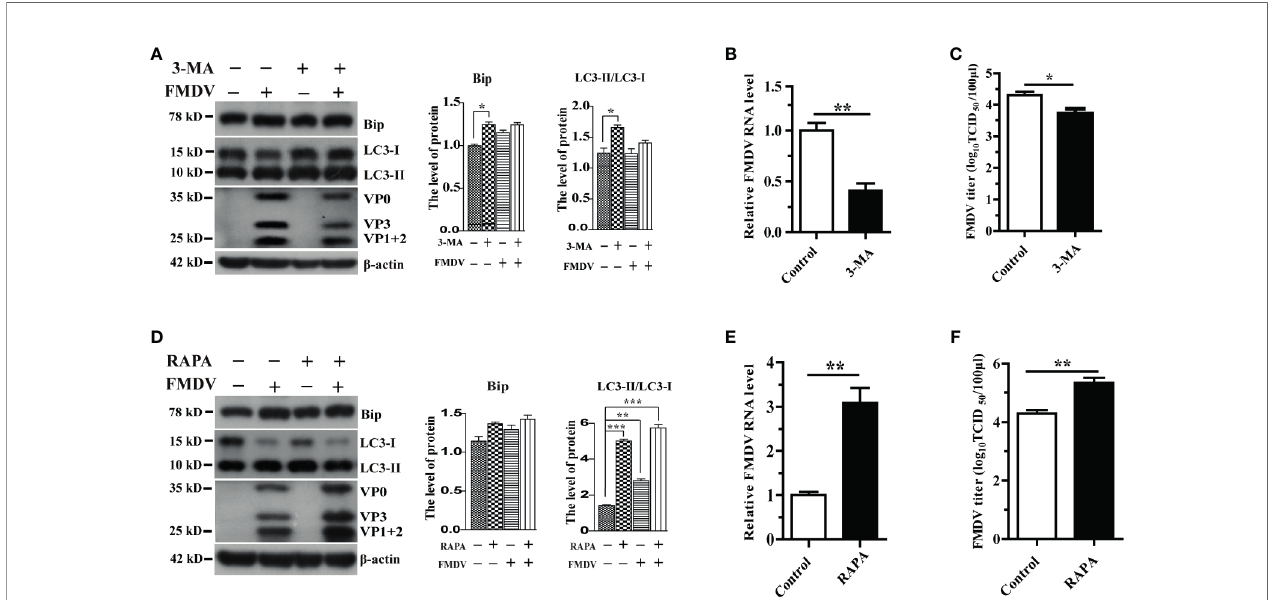
FIGURE 2 | The effect of autophagy on FMDV replication in pharmacologically treated PK-15 cells. (A) PK-15 cells were treated with a complete medium containing 3 mM 3-MA for 5 h and then infected by FMDV. Cell samples were processed and subjected to Western blotting at 5 hpi. The existence of 3-MA was indicated with “ +. ” The levels of related proteins were normalized to b -actin; data were expressed as means ± SD of three experiments. Every treatment group compared with control groups, respectively; * p < 0.05, ** p < 0.01. (B , C) Viral mRNA and viral progeny yields were examined based on qRT-PCR analysis and TCID 50 ; (D) 500 nM RAPA-treated PK-15 cells were infected by FMDV; and cell lysates were harvested for Western blot analysis at 5 hpi. The existence of RAPA was indicated with “ +. ” The levels of related proteins were normalized to b -actin; data were expressed as means ± SD of three experiments. Every treatment group compared with control groups, respectively, * p < 0.05, ** p < 0.01, *** p < 0.001. (E , F) Viral mRNA and viral progeny yields were examined based on qRT-PCR analysis and TCID 50 . Data are analyzed as mean ± SD; * p < 0.05, ** p <